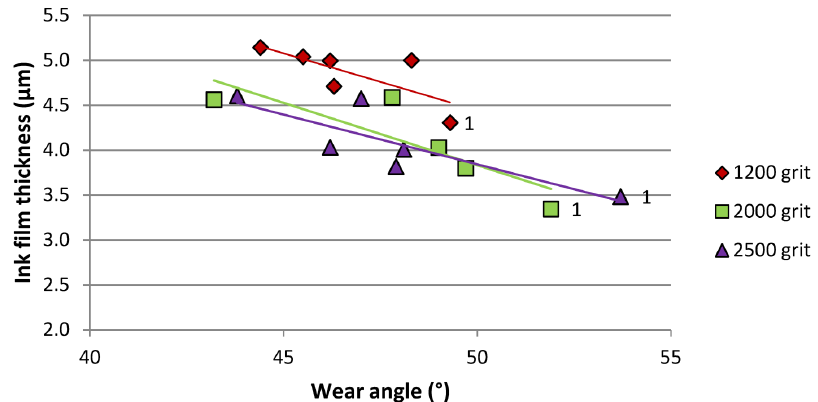
Figure 14. Ink film thickness vs . wear angle in worn